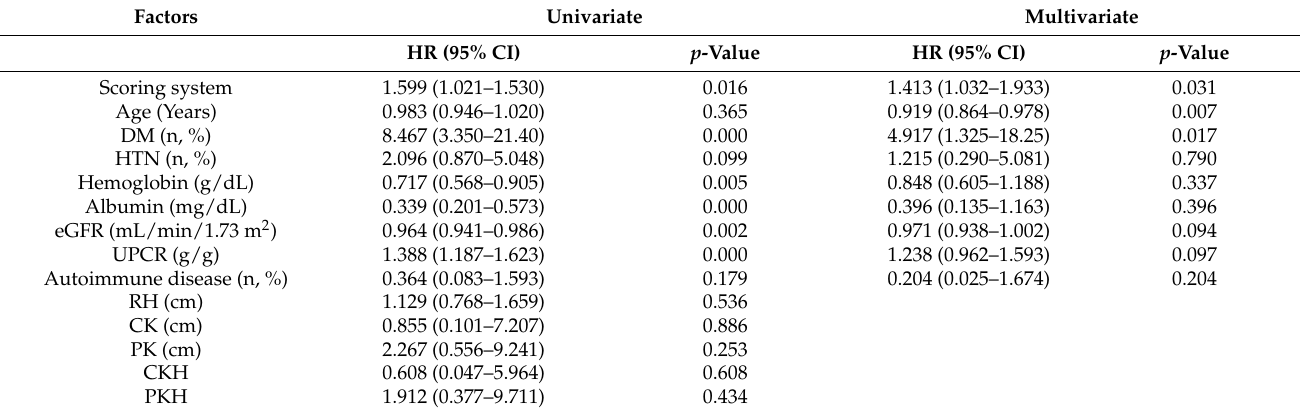
Table 5. Logistic regression analysis for the occurrence of renal